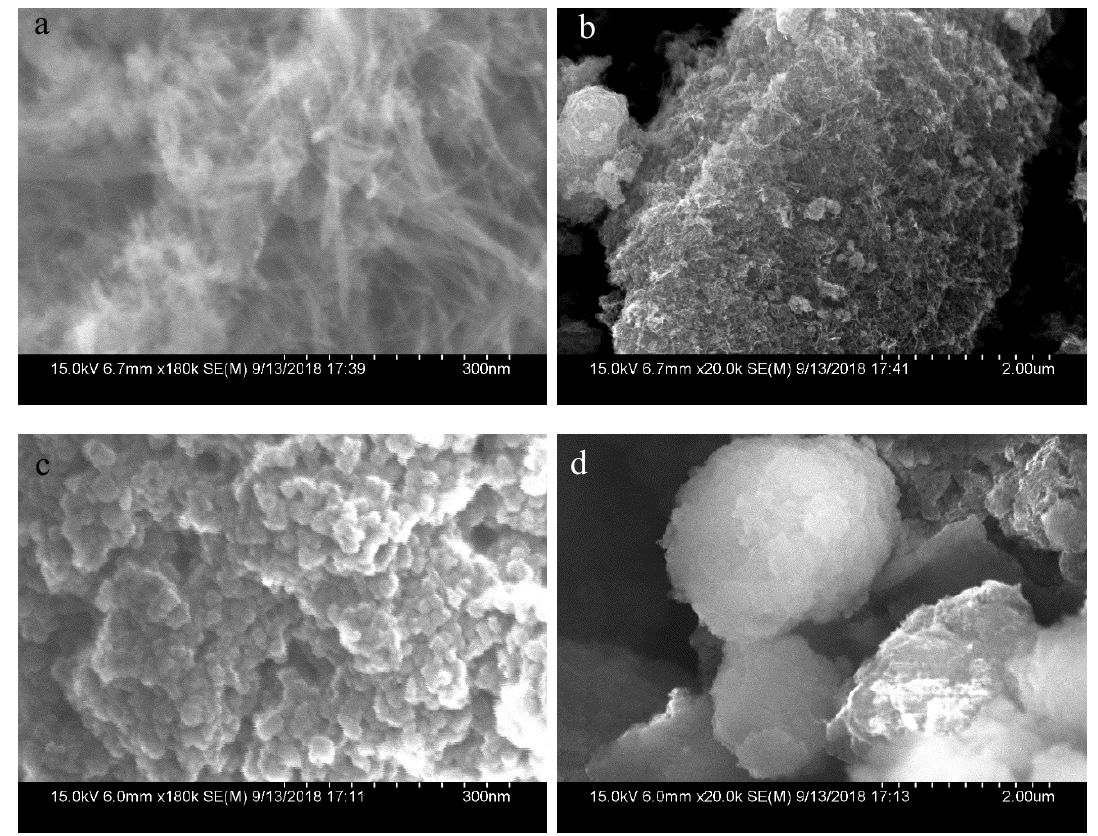
Figure 7. The morphology changes of Mn 3 O 4 before and after reaction with phenol ( a ) Mn 3 O 4 before reaction with magnification of 180,000×; ( b ) Mn 3 O 4 before reaction with magnification of 20,000×; ( c ) Mn 3 O 4 after reaction with magnification of 180,000×; ( d ) Mn 3 O 4 after reaction with magnification of 20,000×. Nanomaterials 2020 , 10 , x FOR PEER REVIEW